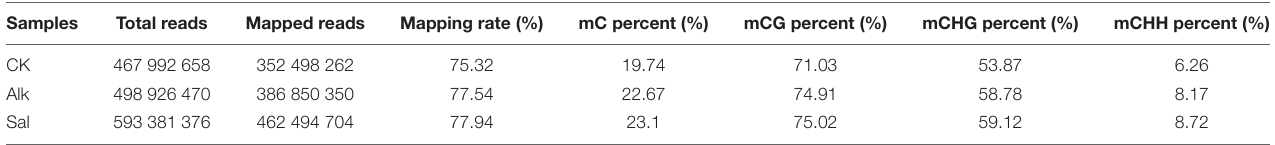
FIGURE 2 | Epigenome of G. barbadense. (A) Circle graph of the methylation distribution within chromosomes. The outermost circle is a scale based on the length of the corresponding chromosome. The following three circles (from outside to inside) represent the methylation background display of CG, CHG, and CHH, respectively, in the corresponding chromosome interval of the PF group in red, purple, and blue, respectively. The denser color line indicates the higher level of methylation background. The innermost circle indicates the number of genes in the corresponding interval, and the darker color indicates the greater number of genes in the region. (B) Circos plot showing the level and density of 5-mCs in the three sequence contexts and the gene density for all 26 chromosomes of the G. barbadense genome. For the line graph of the level and density of 5-mCs, the CG, CHG, and CHH sequence types are displayed as red, blue, and purple lines, respectively. (C) Relative proportions of mCs in CG, CHG, and CHH contexts across the genome of G. barbadense hypocotyl. TABLE 1 | Statistical results of methylated cytosines in different